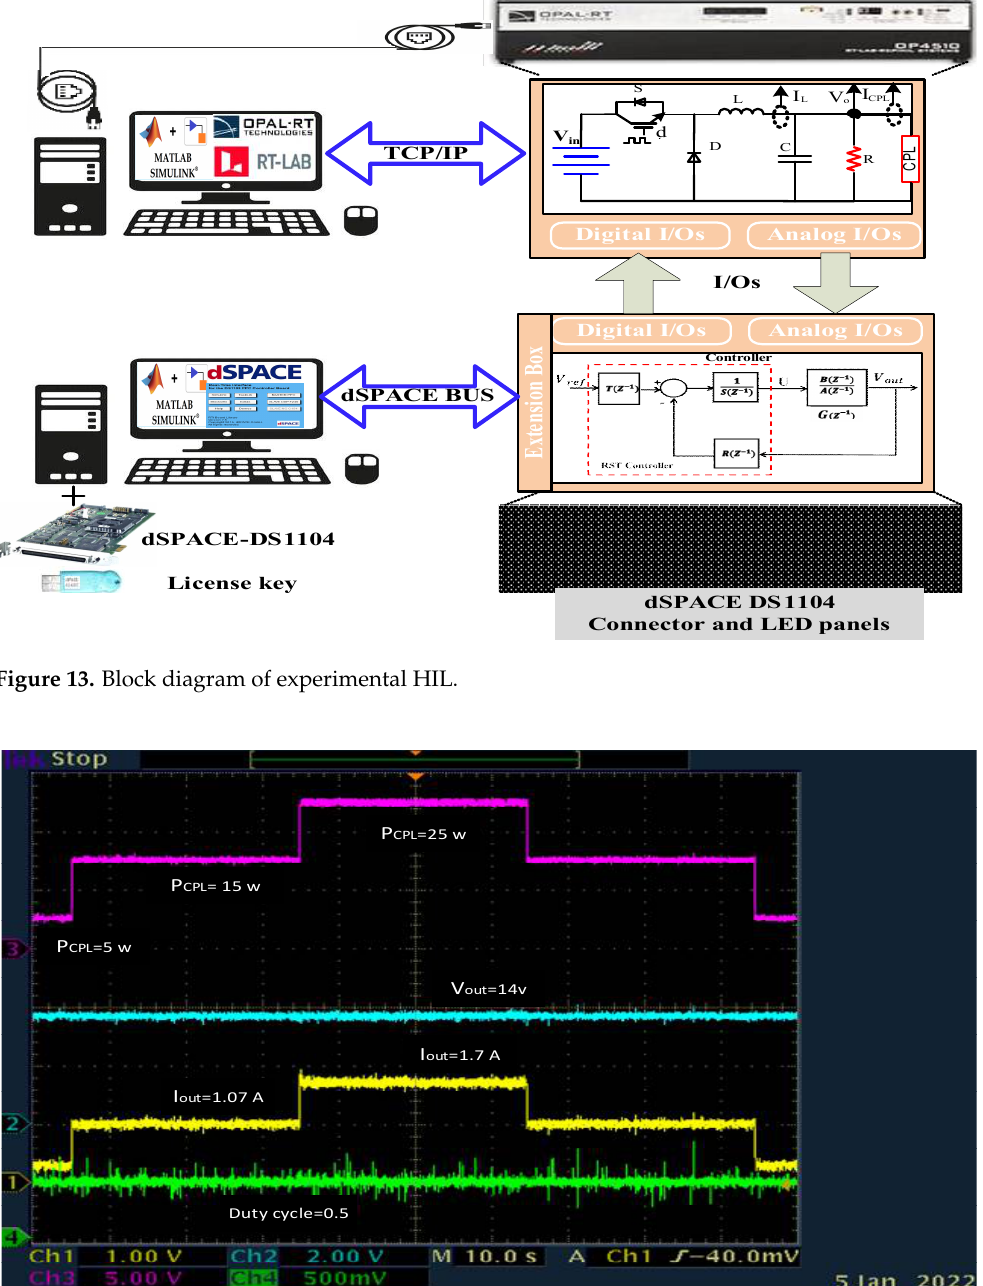
Figure 14. HIL experimental results of system with CPL variation.